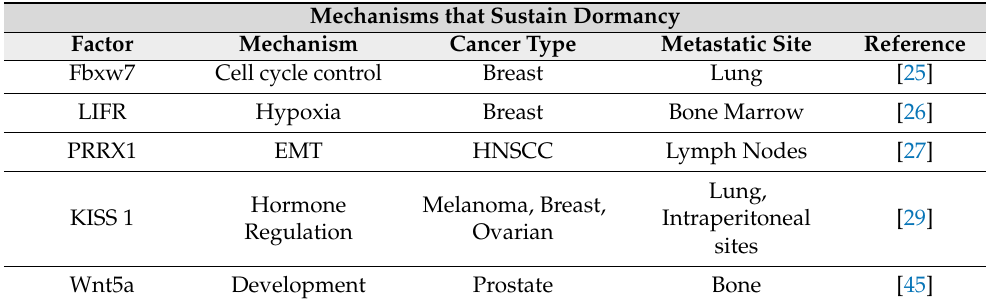
Table 1. Factors implicated in the mechanisms sustaining dormancy or escape from